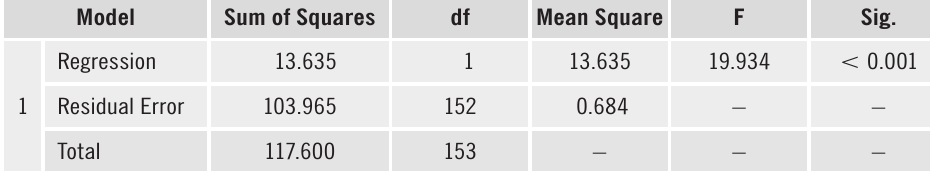
Table 10. Anova: the level of market orientation and competitiveness index Model